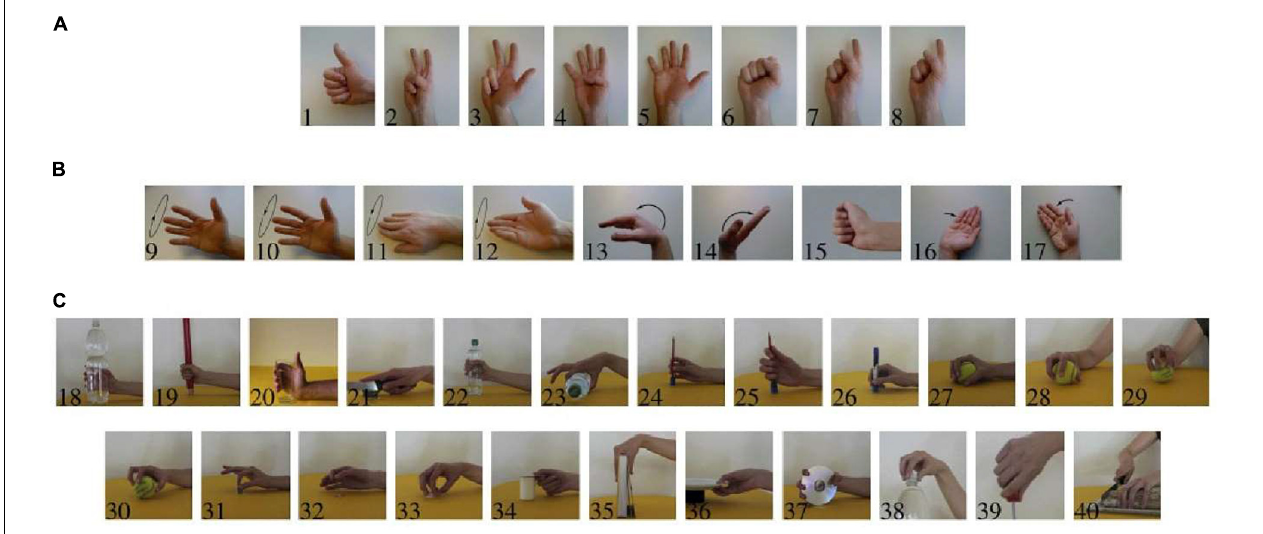
FIGURE 1 | Forty movements included in the acquisition protocol. (A) Isometric, isotonic hand configurations (“hand postures”). (B) Basic movements of the wrist. (C) Grasping and functional movements [modified from Atzori et al. (2014a), with